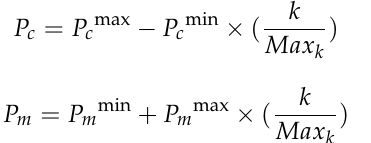
Figure 5. The execution on step of elitist strategy.